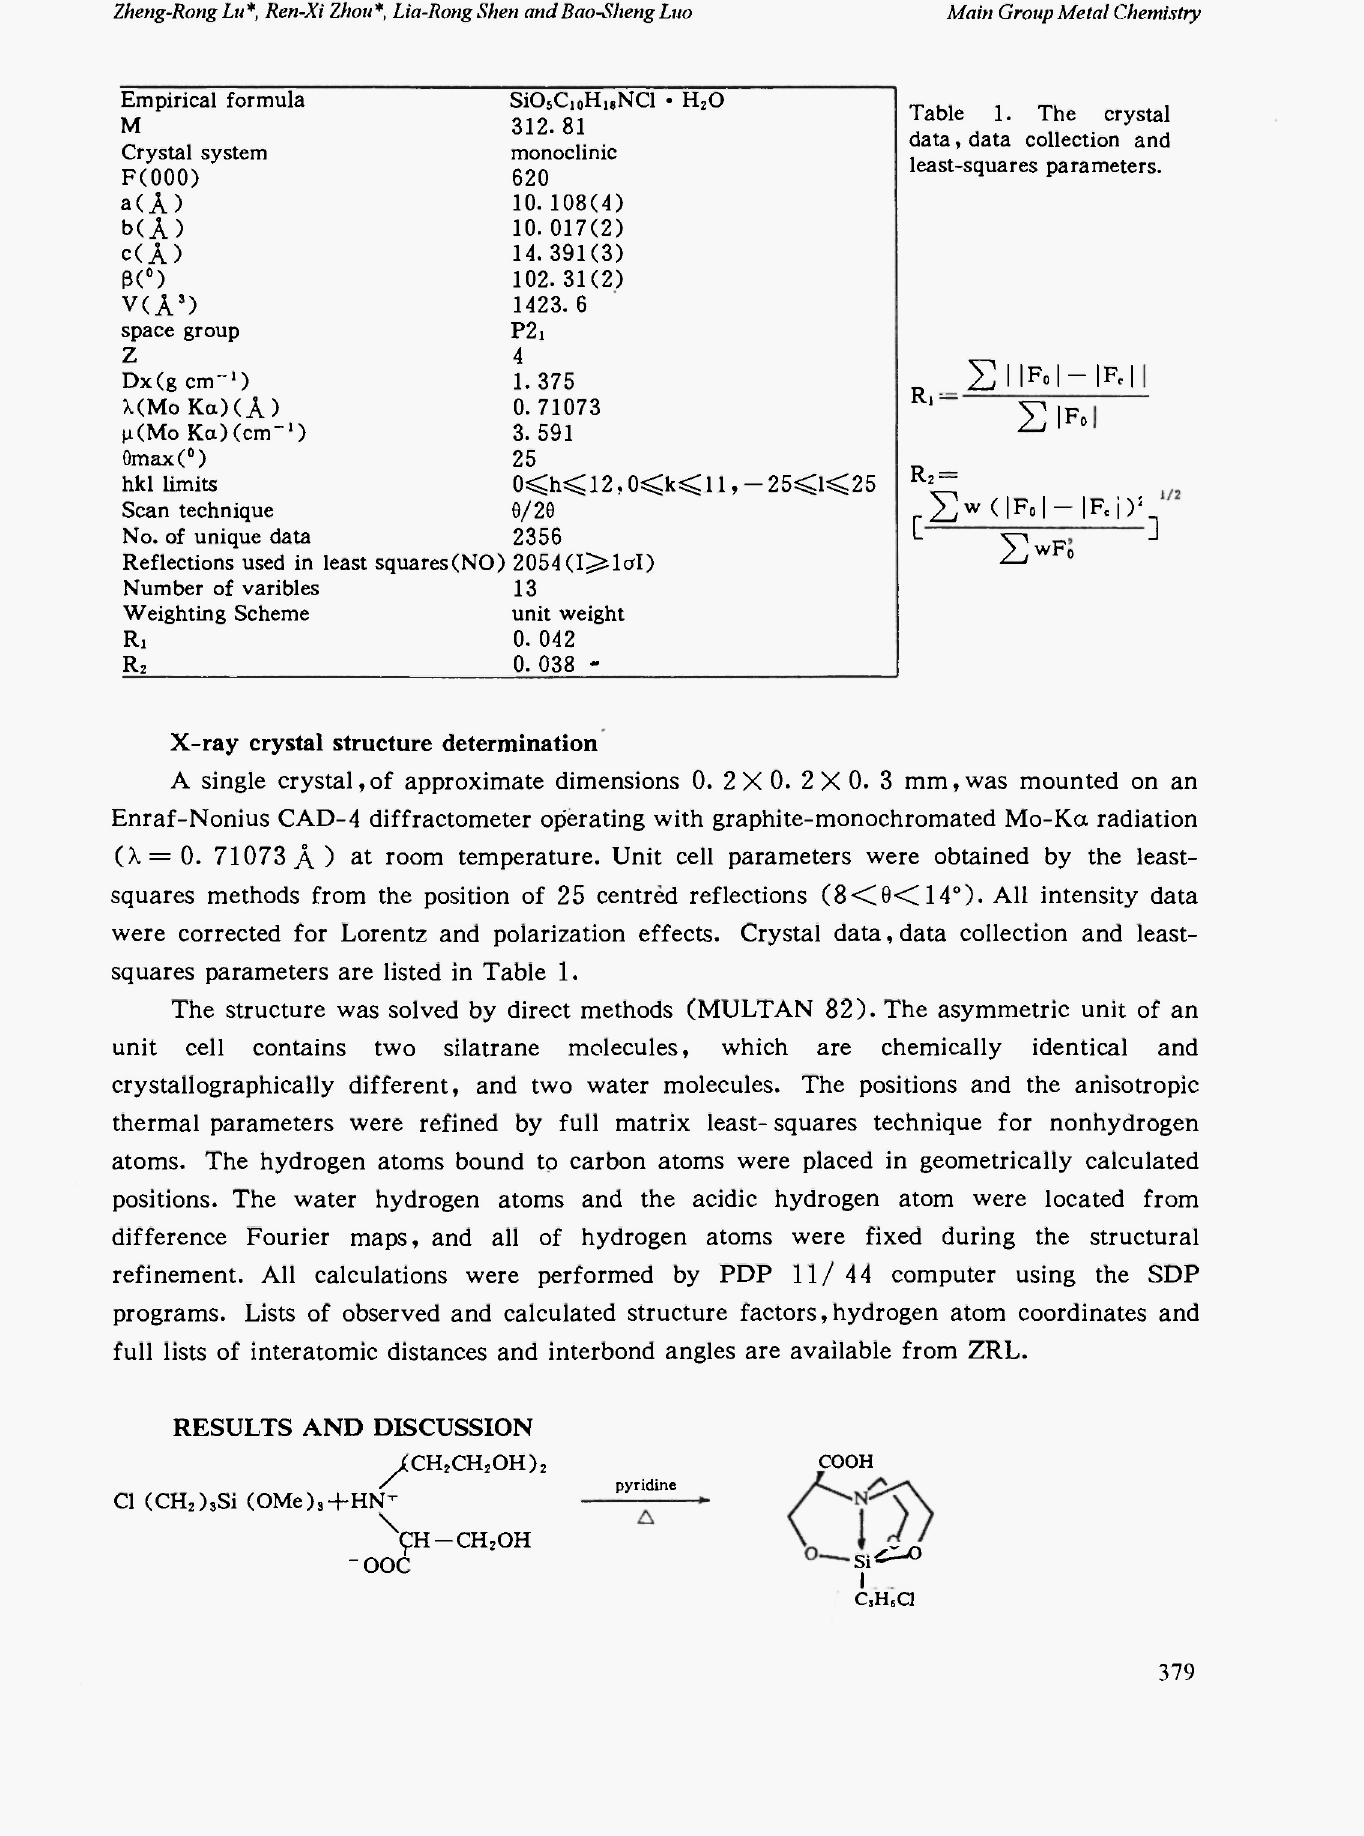
The data, data collection and least-squares